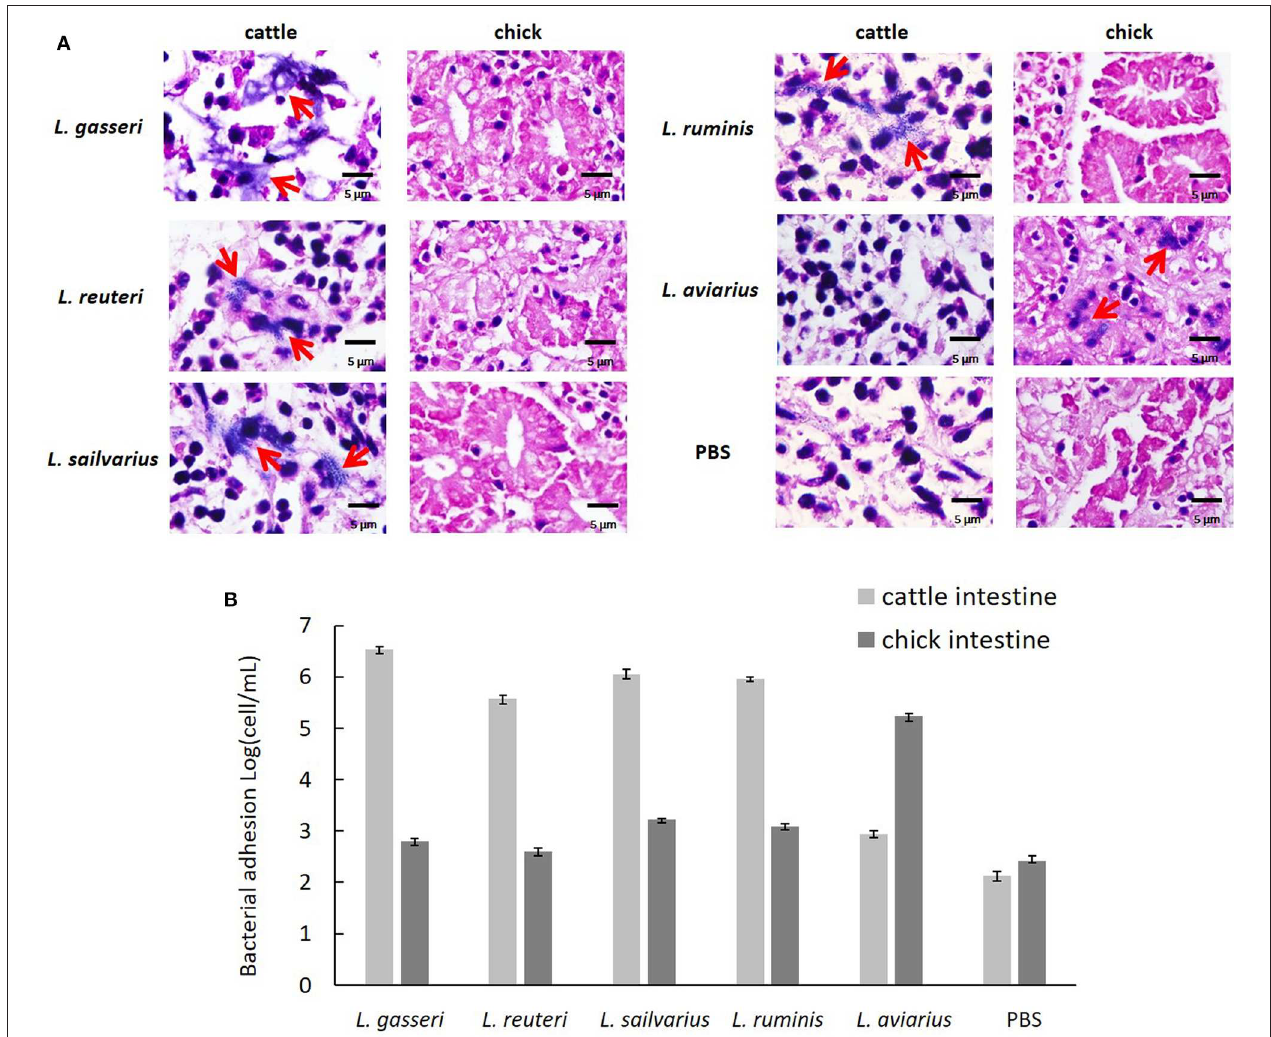
FIGURE 4 | Ex vivo adhesion of the Lactobacillus strains to intestinal epithelial cells. (A) Adhesion of cattle ileum and chick intestine was examined using light microscopy ( × 400) after Gram staining. Red arrowhead indicates adhered bacteria. (B) Quantification of bacteria adherent to intestinal epithelial cells by the Neubauer counting chamber using a light microscope. Lactobacillus ruminis and L. aviarius isolated, respectively, from bovine rumen and chicken feces served as reference strains. Phosphate-buffered saline was used as a negative